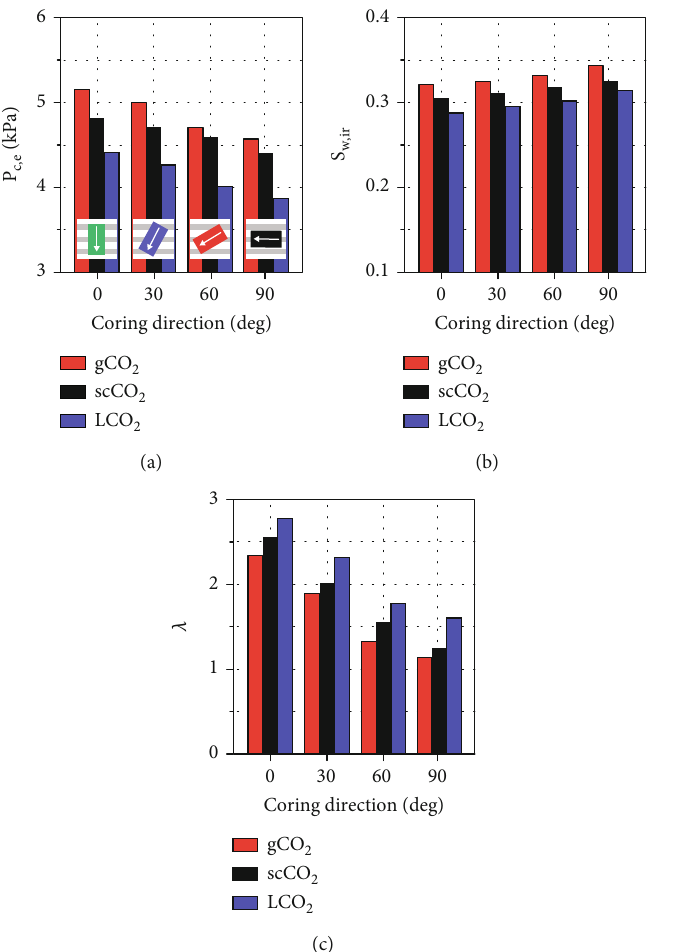
Figure 5: Brooks-Corey parameters estimated from capillary pressure curves when injected with gCO ), (b) the irreducible residual water saturation ( S entry pressure ( P c,e